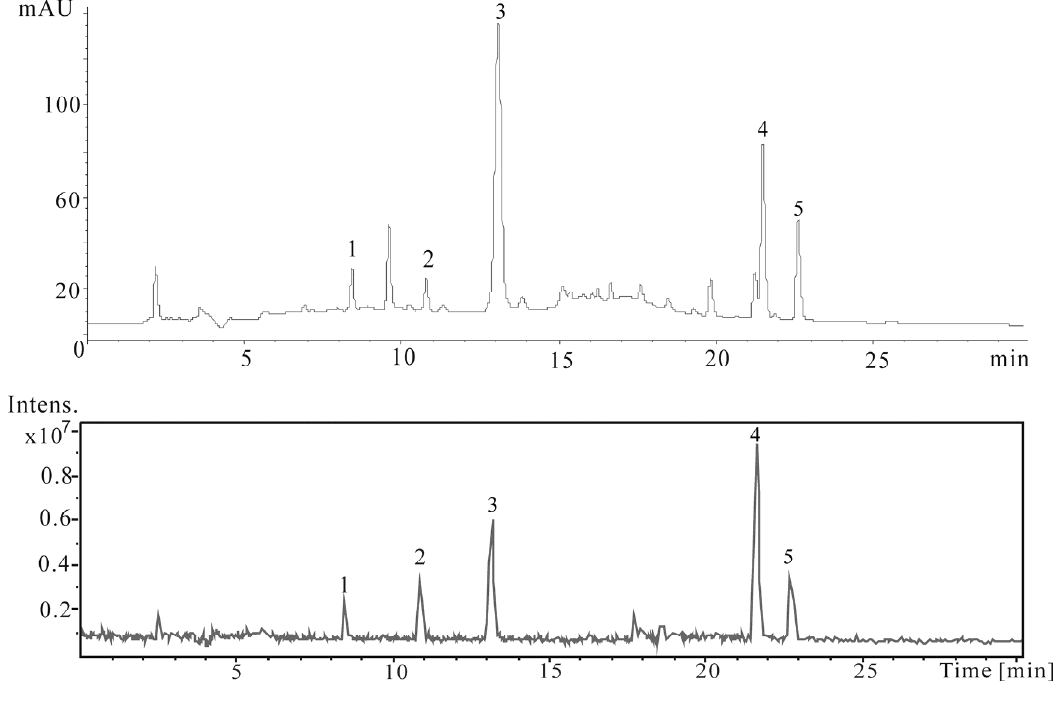
Figure 1. HPLC chromatogram obtained by UV detection at 280 nm and TIC chromatogram of the crude extract from lotus leaves in the positive ESI-MS mode.